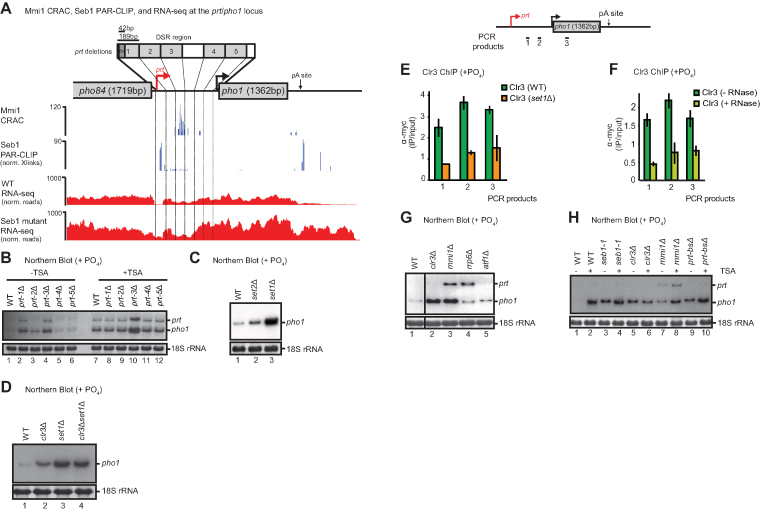
Mapping the contribution of specific regions of prt ncRNA to pho1 silencing. (A) Schematic of pho1 locus with deletions of prt regions as indicated by numbered grey boxes. Mmi1 CRAC and Seb1 PAR-CLIP signals are shown in blue and WT and Seb1 mutant S22D-K25E-K124E RNA-seq signals are shown in red. (B–D) Northern blot analysis of RNA isolated from the indicated strains grown in YES. Schematic of the pho1 gene is shown with qPCR products indicated by black bars. (E) Clr3-myc ChIP-qPCR analysis over the pho1 locus in WT or set1Δ. (F) Clr3-myc ChIP-qPCR analysis over the pho1 locus either untreated (–) or treated (+) with RNase. (G, H) Northern blot analysis of RNA isolated from the indicated strains grown in YES. 18S ribosomal RNA serves as a loading control. Probes used are the same as in Figure 1A.